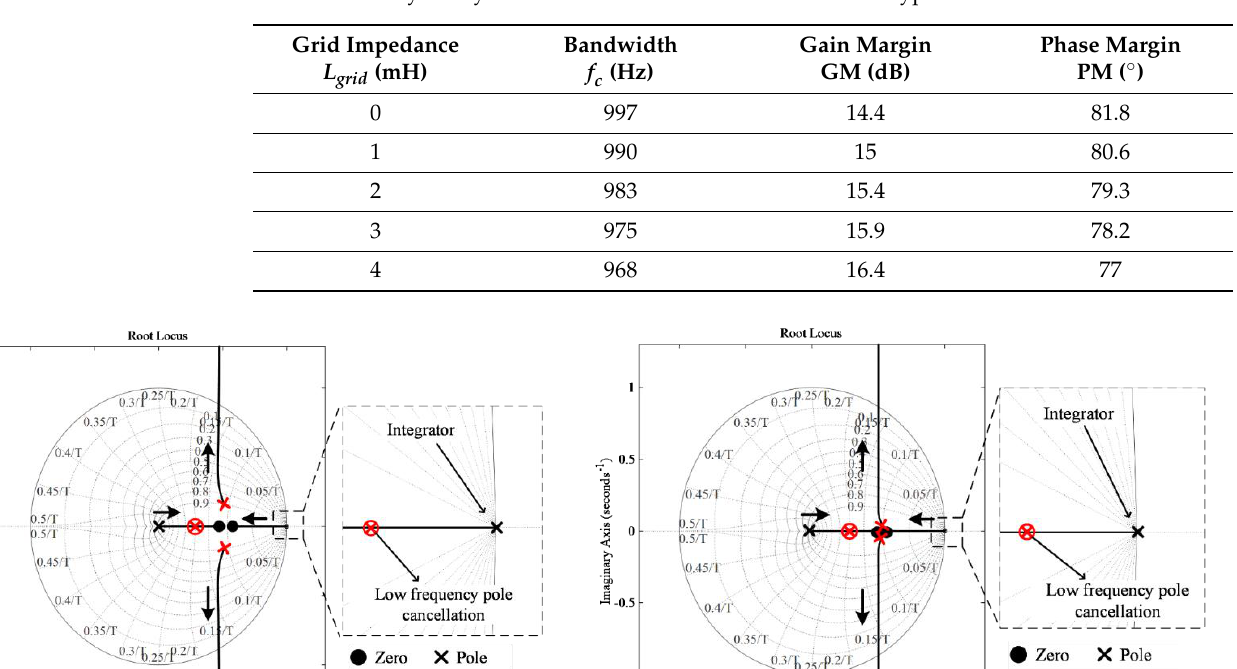
Figure 9. Loop gain Bode plots for L filter type GcI with FESO-based ADRC under L grid variation. Table 4. Stability Analysis of FESO-Based ADRC for the L Filter Type GcI.